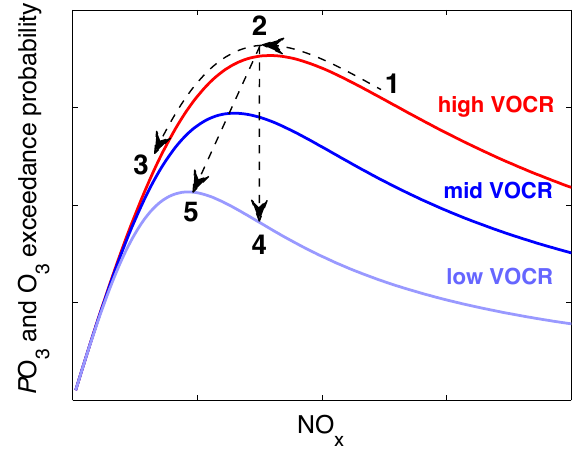
Fig. 2. The instantaneous ozone production rate ( P O 3 ) and, by analogy the ozone exceedance probability, as a function of NO x is shown for three categories of organic reactivity (VOCR): high (red), mid (blue), and low (violet). The mid- and high-VOCR curves correspond to scaling the base VOCR by 2 and 3, respectively. If temperature serves as an adequate proxy for VOCR then the three curves will also describe high- (red), moderate- (blue), and low- (violet) temperature